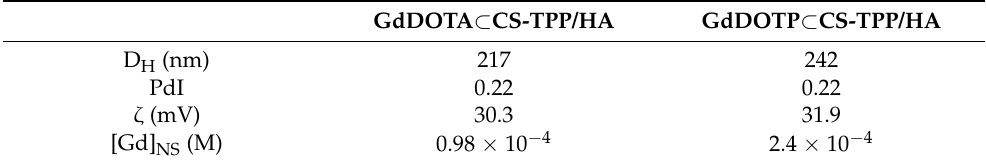
Table 1. Physico-chemical properties of the purified nanogels. GdDOTA ⊂